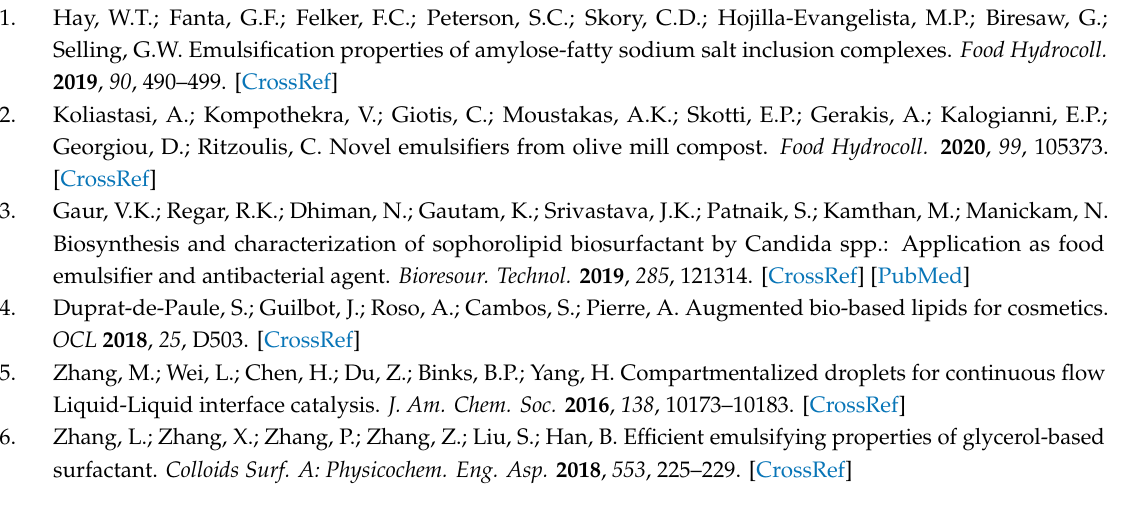
Figure S1: FT-IR spectra of the XEHR and the hydrogenated rosin; Figure S2: 1 H and 13 C NMR spectra obtained from the